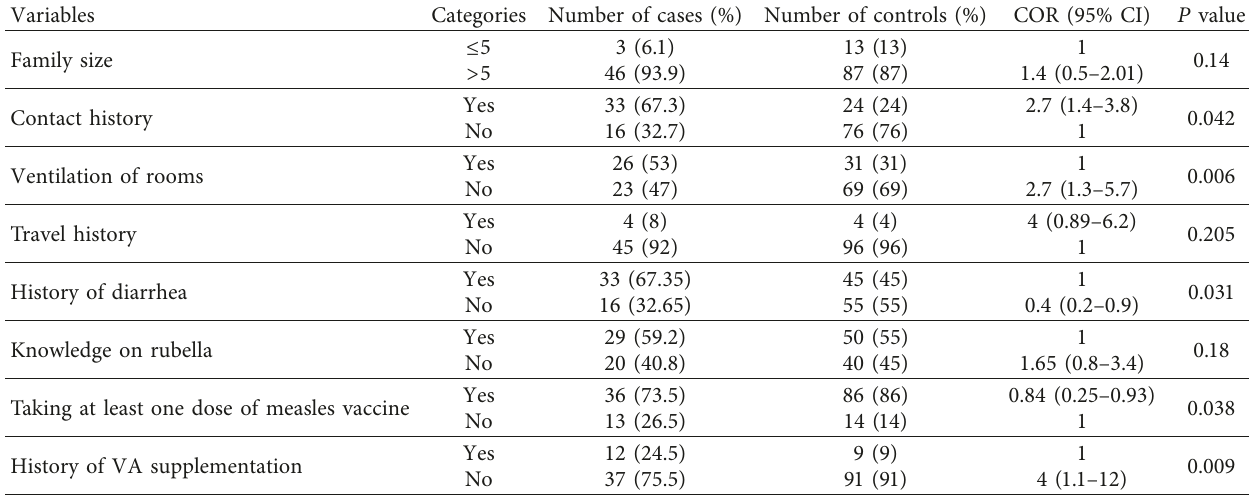
Table 3: Factors associated with rubella infection on bivariate analysis in Amuma Wuchale Kebele, Kuyu District, North Shewa Zone, Oromia Region, 2018.